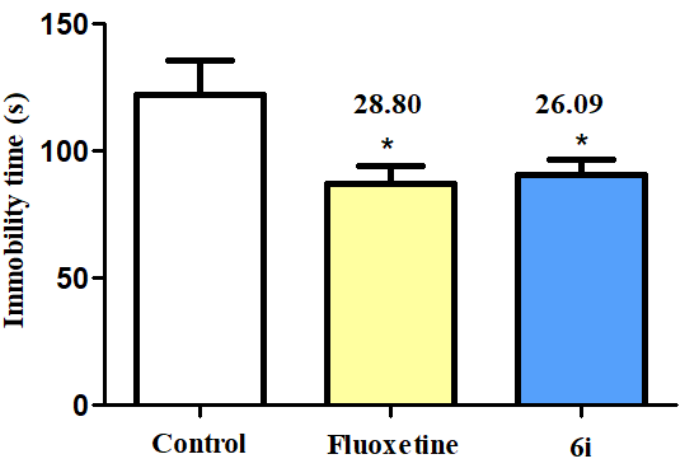
Figure 3. Antidepressant activities of compounds 6i and Fluoxetine in the TST test. Compounds 6i and Fluoxetine were administered at 40 mg/kg. Values represent the mean ± SEM ( n = 8). * Significant compared to control (0.01 < p < 0.05).